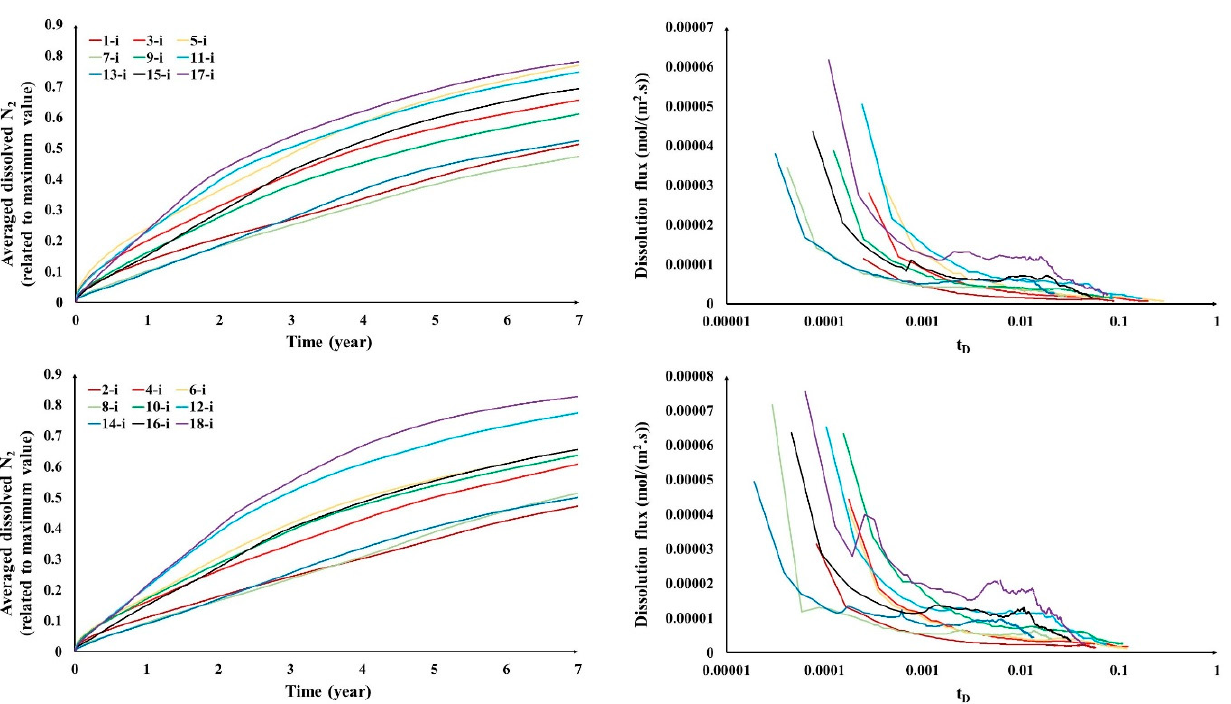
Figure 6. The averaged dissolved N 2 and dissolution flux for impure cases. Legends for left- and right-hand subplots are same.